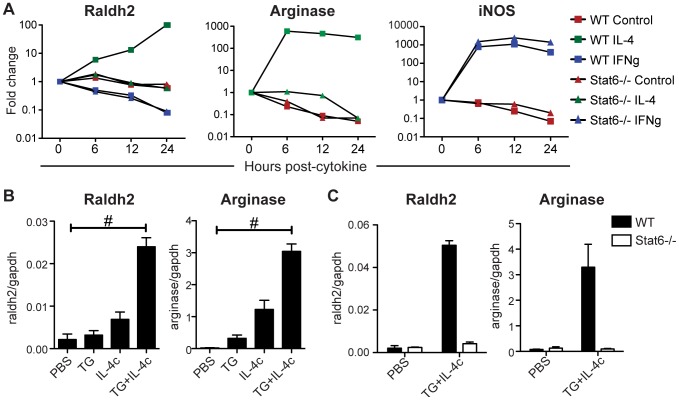
IL-4 induces Stat6-dependent Raldh2 expression in macrophages in vitro and in vivo.(A) qRT-PCR analysis of cytokine-treated bone marrow-derived macrophages from WT and Stat6−/− mice. Expression is normalized to HPRT and presented as a fold-change above untreated cells. (B, C) qRT-PCR analysis of peritoneal macrophages elicited by i.p. administration of thioglycollate (TG) and/or IL-4 complexes (IL-4c) from WT and Stat6−/− mice. Expression is normalized to GAPDH. n = 2–4 mice per group. Error bars illustrate SEM; #p<0.001. Results are representative of two (B) or three (A) independent experiments.